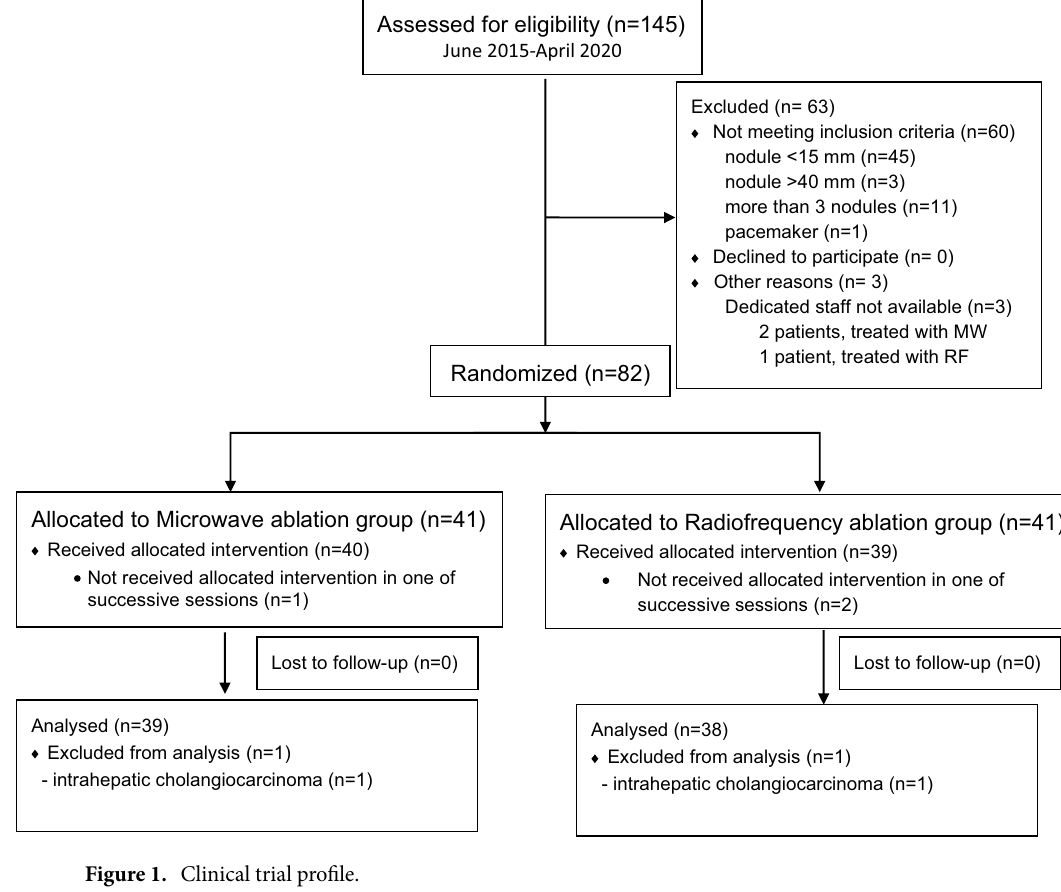
Figure 1. Clinical trial